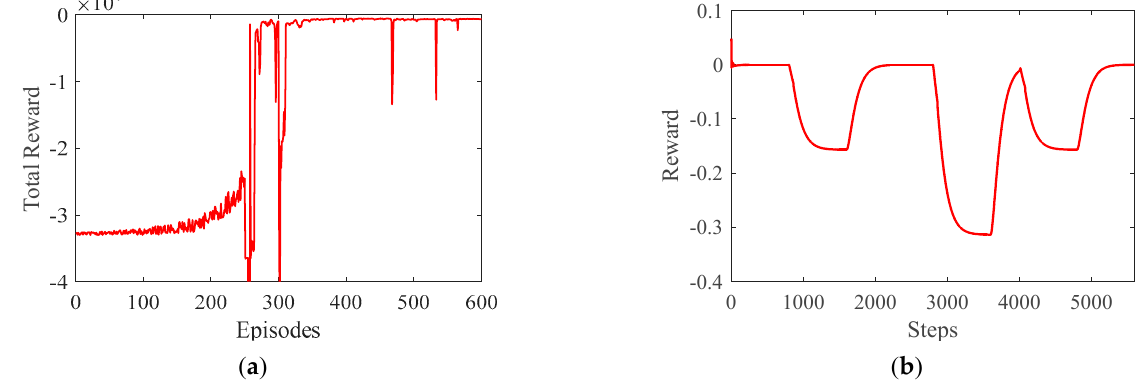
Figure 7. Performance of total reward per episode and reward per step. ( a ) Total reward per episode. ( b ) Reward per step.